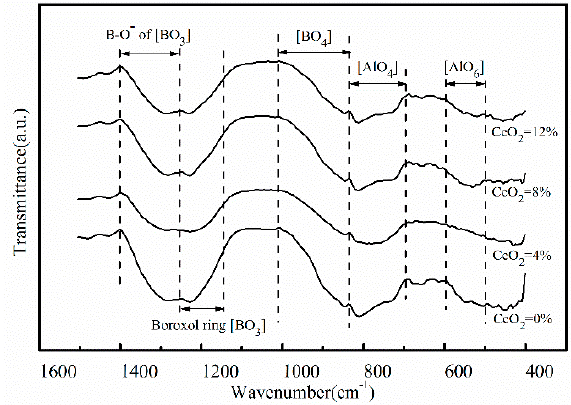
Figure 7. The Fourier-transform infrared spectroscopy (FTIR) spectra of the experimental mold fluxes with different CeO 2 content.